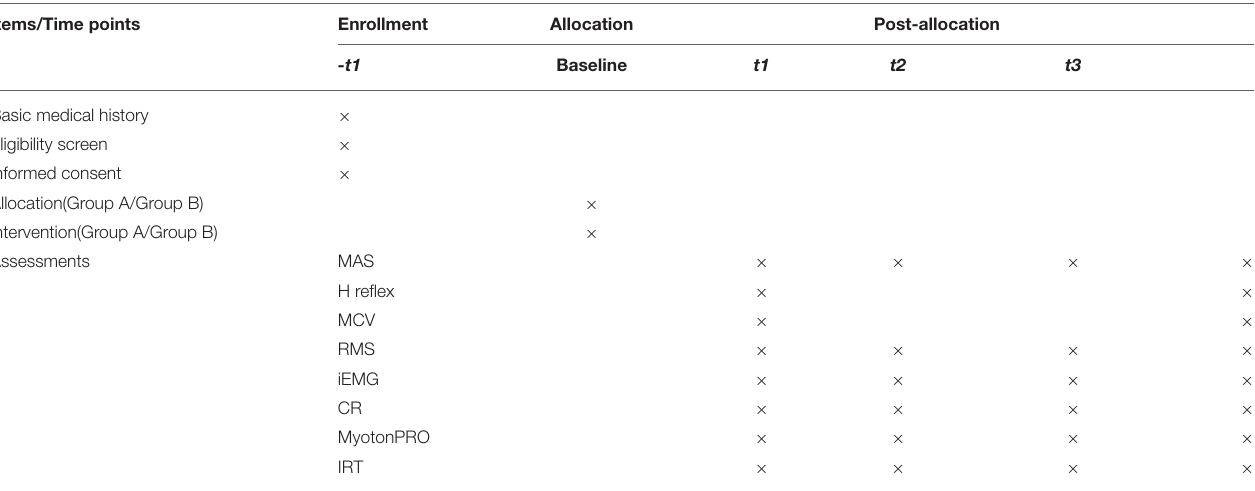
TABLE 2 | Flow chart of the